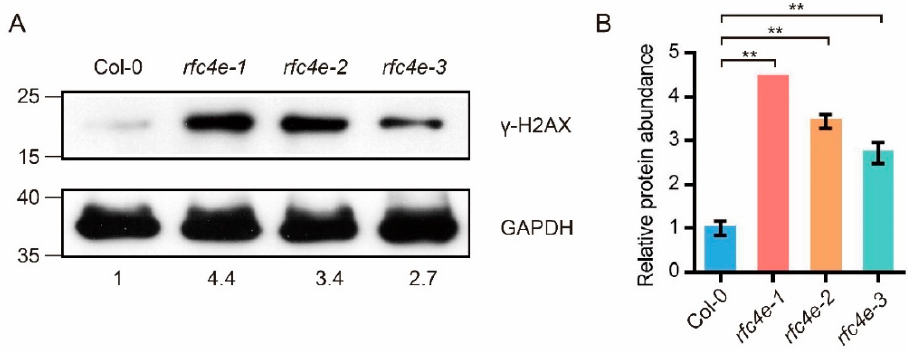
Figure 4. Detection of histone H2AX phosphorylation in wild-type and rfc4e plants. ( A ) The 12 − d − old Col − 0, rfc4e − 1 , rfc4e − 2 and rfc4e − 3 plants were used to extract total protein. Immunodetection of γ - H2AX was carried out using rabbit anti - γ - H2AX polyclonal antibody in total protein extracts. The upper panels in Figure 4A represent Western blots from standard - condition seedlings, while the lower panels indicate expression levels of GAPDH protein; anti - GAPDH antibody was detected and used as a loading control. Molecular mass markers in kilodaltons are indicated on the left. ( B ) The relative γ - H2AX band intensity normalized to loading control, relative to Col − 0. The experiment was repeated two times with the same tendency. Error bars indicate ±SD (** p < 0.01).